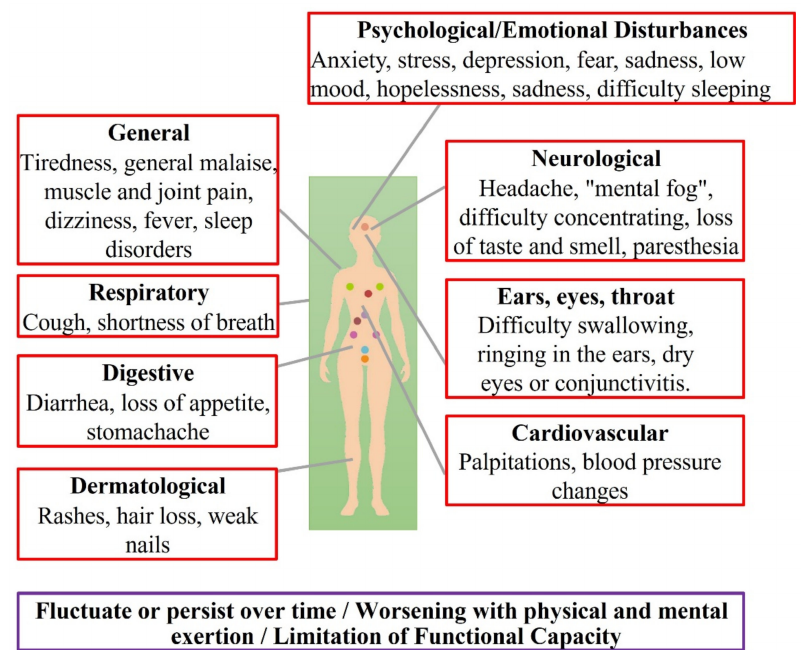
Figure 2. Symptomatology associated with Long